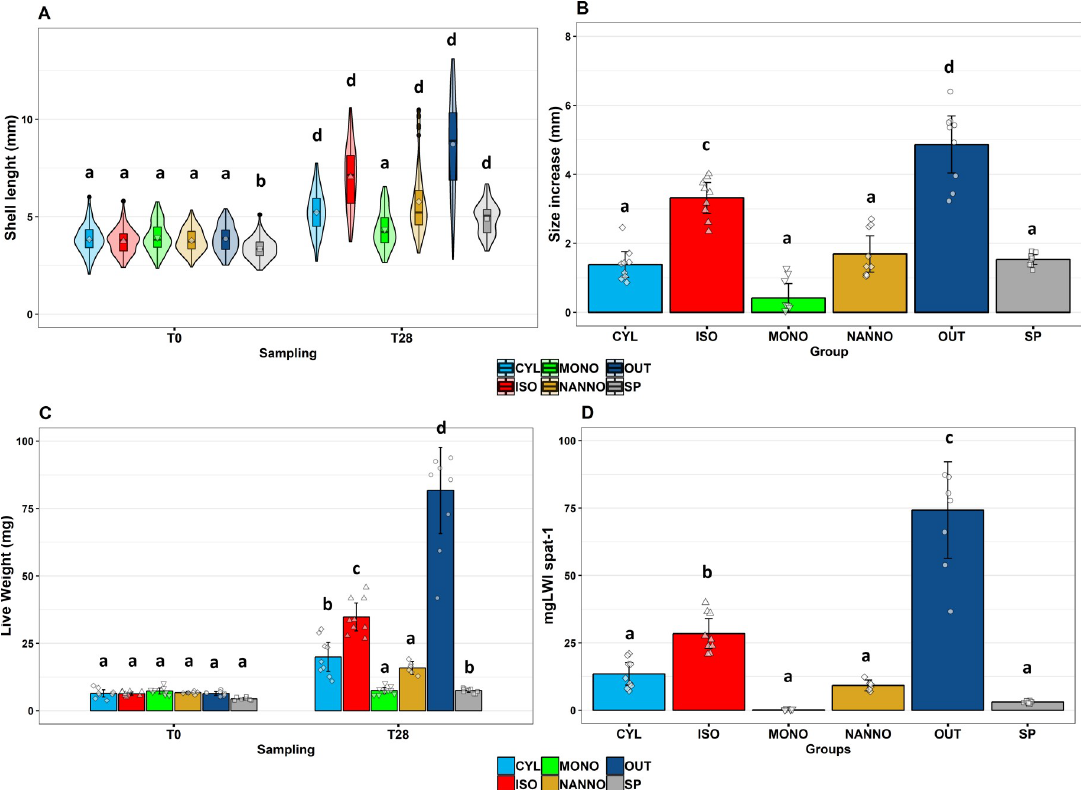
Fig 2. Spat growth performances when subjected to the different diet treatments. A: variation of shell length in mm between in each group between the beginning of the trial (T0) and end of the experiment (T28). B: Size increase of the spat (reported in mm) during the diet trial when subjected to different diets. C: live weight per spat (reported in mg) between the beginning of the trial (T0) and the end of the trial (T28 D: weight increase per spat throughout the trial according to the different sample groups (reported in mg). SP: spat subjected to Shellfish Paste, CYL: spat subjected to C. fusiformis 1017/2, ISO: spat subjected to I. galbana 927/1, MONO: spat subjected to M. subterranean 848/1, NANNO: spat subjected to N. oceanica 849/10, OUT: Outdoor deployed spat. A: N = 90 individual spat per group, marker in each box plot indicates the group average, band inside the box indicates the group median, box includes observation between 1 st (25 th percentile) and 3 rd (75 th percentile) quartile, whiskers represent values between ± 1.5 � interquantile range (IQR), observations outsite over ± 1.5 � IQR are reported as outliers (black dots); violin shapes represent the variable distribution in each sample group. Figs B-C-D: N = 9, histograms represent the average ein each group and errobars the confidence interval for 95% of observations, single observation are jittered as small dots inside each histogram. Letters indicate significance levels: a: p > 0.05; b: p < 0.05; c: p < 0.01; d p < 0.001.